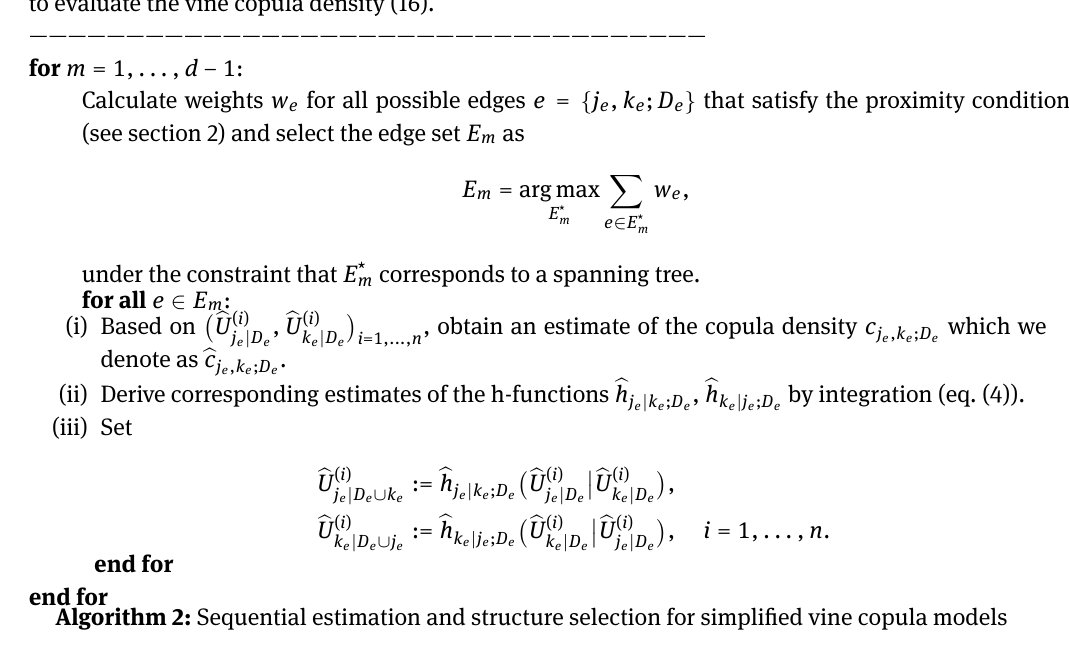
end for Algorithm 2: Sequential estimation and structure selection for simplified vine copula